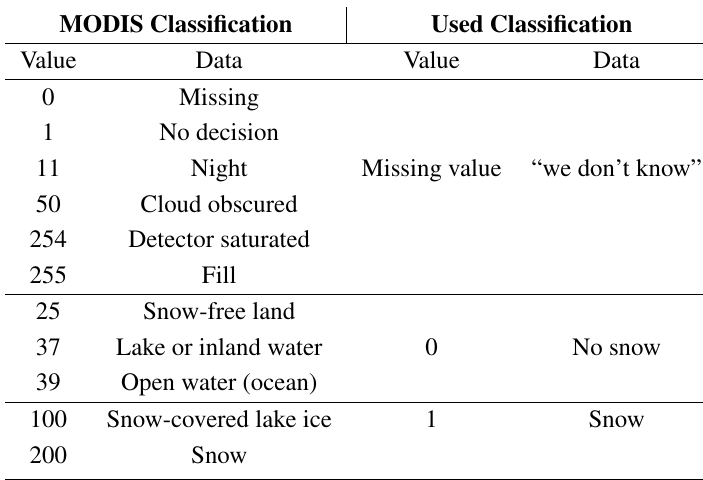
Table 1. Snow categories in the MODIS classification ( left part ) and as used for the preprocessing ( right part ).